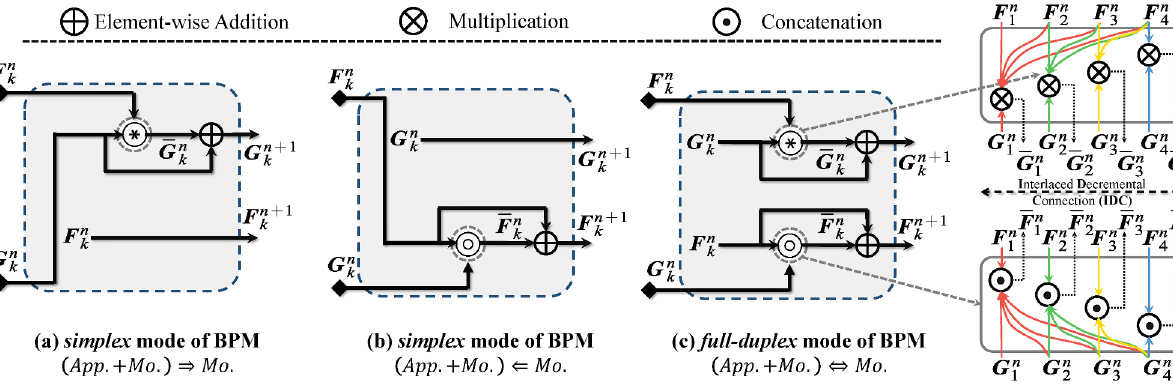
Fig. 5 Bidirectional purification module (BPM) with simplex and full-duplex